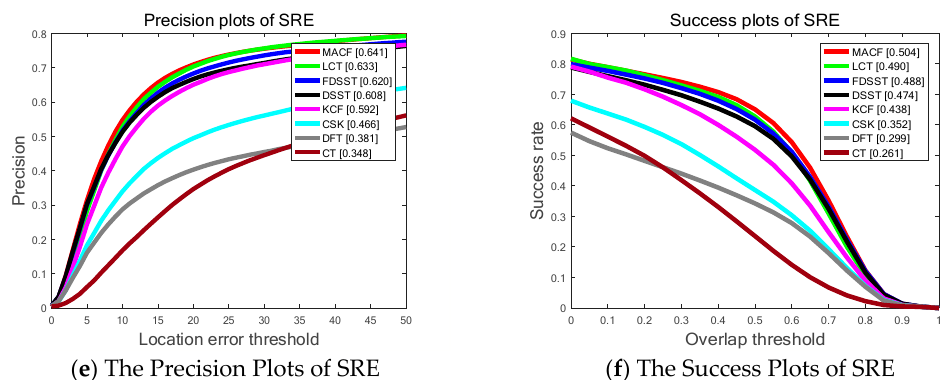
Figure 7. The Success Plots (SP) and Precision Plots (PP) of One Pass Evaluation (OPE), Temporal Robustness Evaluation (TRE) and Spatial Robustness Evaluation (SRE) using by Overlap Threshold (OT) and Location Error Threshold (LET) comparing the MACF with the state-of-the-art trackers on OTB-100 benchmark. In addition, the ranks for the top 8 trackers are reported with the Area Under the Curve (AUC) marked in brackets. Table 3. Success plots of Temporal Robustness Evaluation (TRE) for the MACF and the other 7 top trackers on different attributes: scale variation (SV), illumination variation (IV), out-of-plane rotation (OPR), occlusion (OCC), background cluttered (BC), deformation (DEF), motion blur (MB), fast motion (FM), in-plane rotation (IPR), out-of-view (OV), and low resolution (LR). The last column is the Area Under the Curve (AUC). The best results are in red and the second results are in blue. Trackers